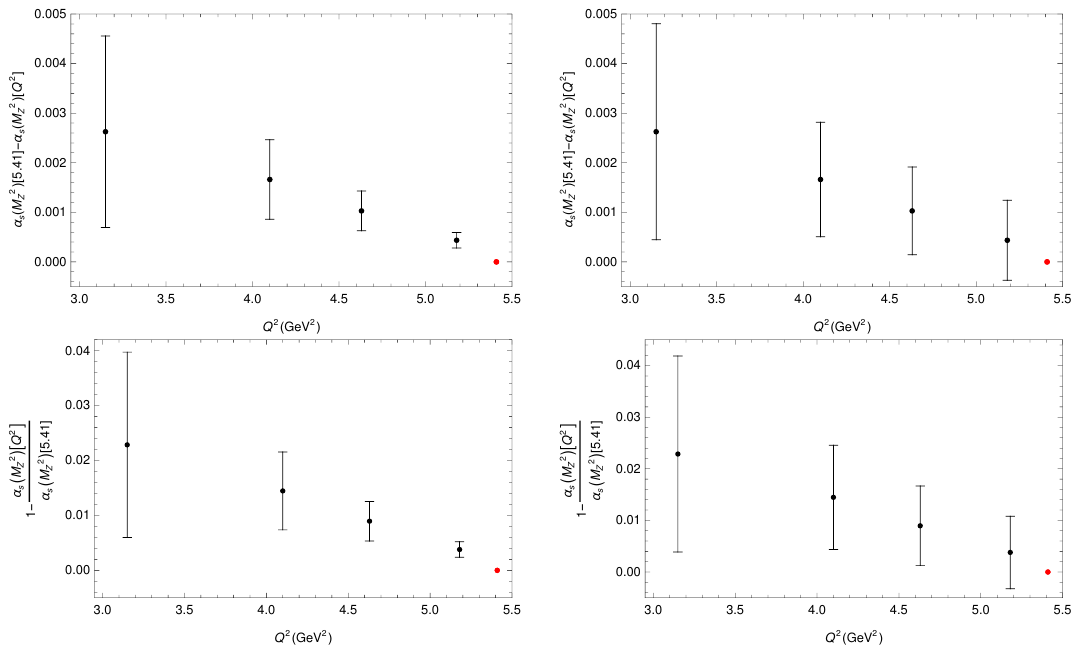
Figure 20 . The top plots show the differences between the extracted α ( n f =5) s ( M 2 ) value at Q 2 = Z 5 . 41 GeV 2 and the rest of extracted values in table 4, together with their uncertainties computed taking into account the correlations. The bottom plots show the same differences normalised with respect to the α ( n f =5) s ( M 2 ) value extracted at Q 2 = 5 . 41 GeV 2 . The red circle indicates the reference Z point at Q 2 = 5 . 41 GeV 2 . For the left plots we assume the theory uncertainties originating from the same source to be fully correlated, whereas for the right plots we assume the theory uncertainties from scale variations and O 6 to be